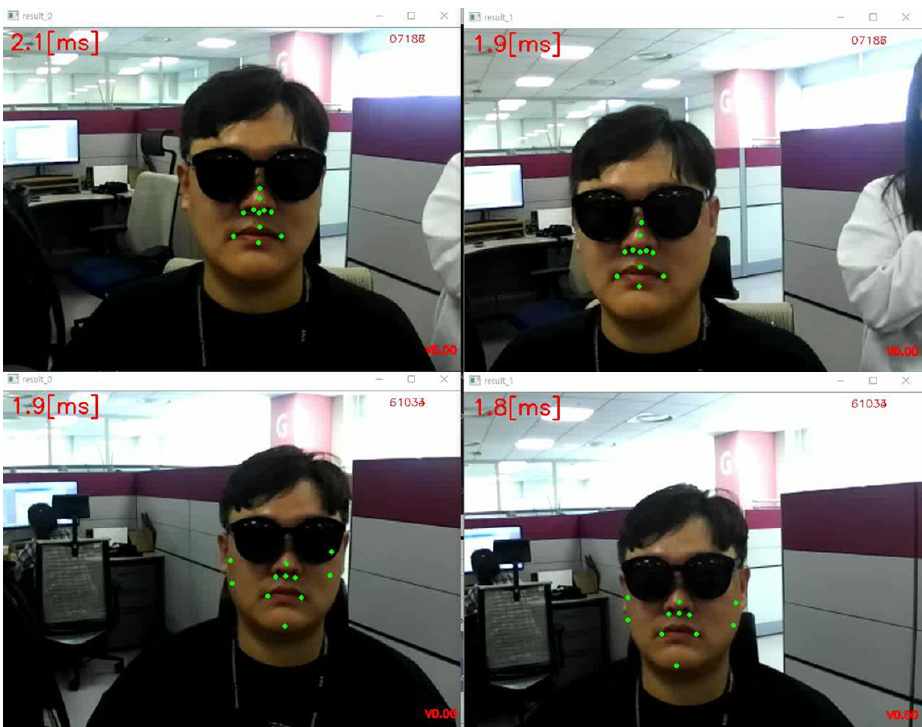
Figure 4. Nonoccluded area shape point candidates identified by a greedy search algorithm: nose– mouth points (1st row) and nose–mouth–face boundary points (2nd row). Each column shows the left and right images from the stereo camera.